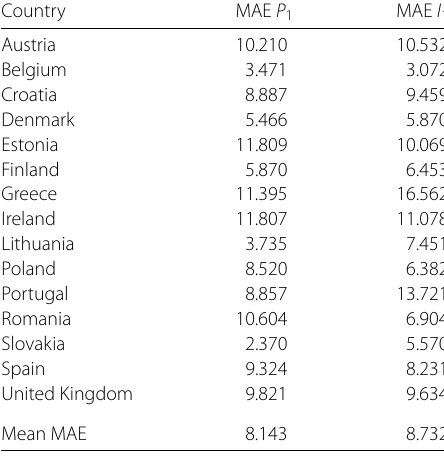
Table 7 Vote share prediction